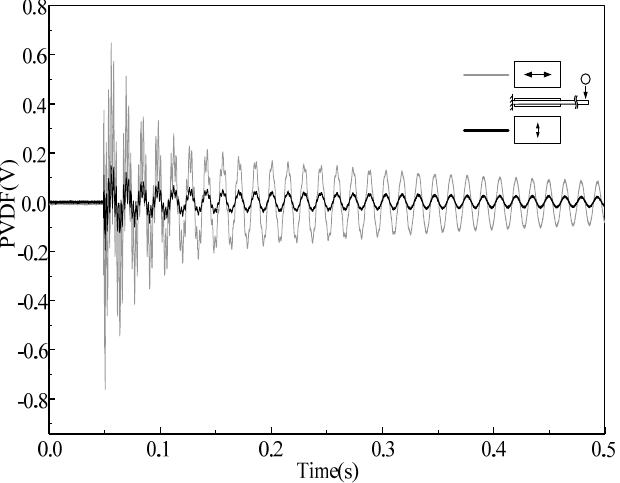
Figure 3. Measurement results of PVDF-U and